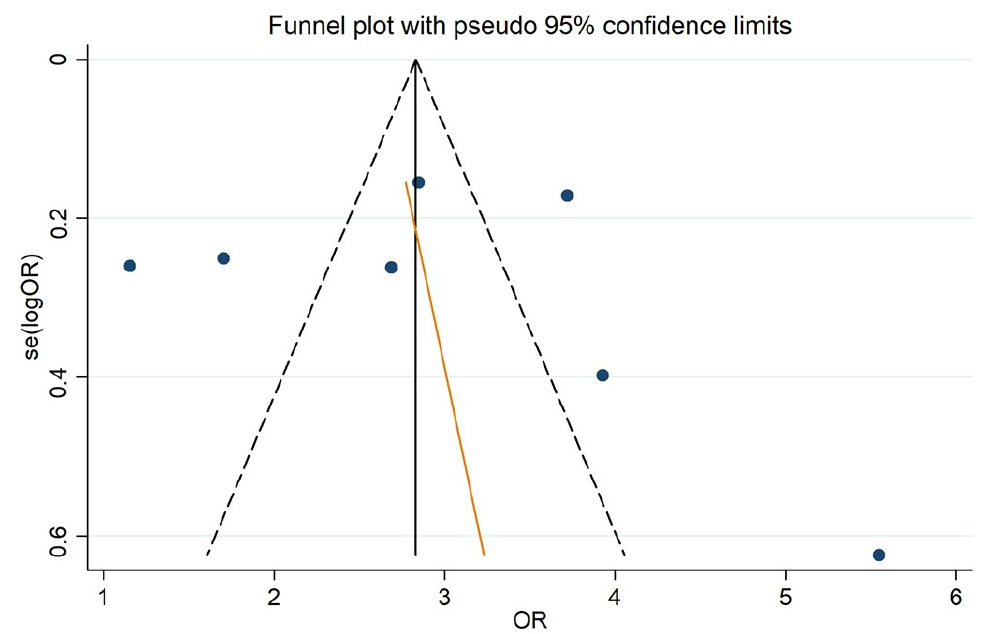
Figure 3. Funnel plot visual to asymmetry. Legend: OR: Odd Ratio. se(logOR): Standard Error of log OR. Dotted black line: the line of pseudo 95% confidence limits. Solid black line: the line of overall effect. Blue point: each study included. Orange line: Egger’s